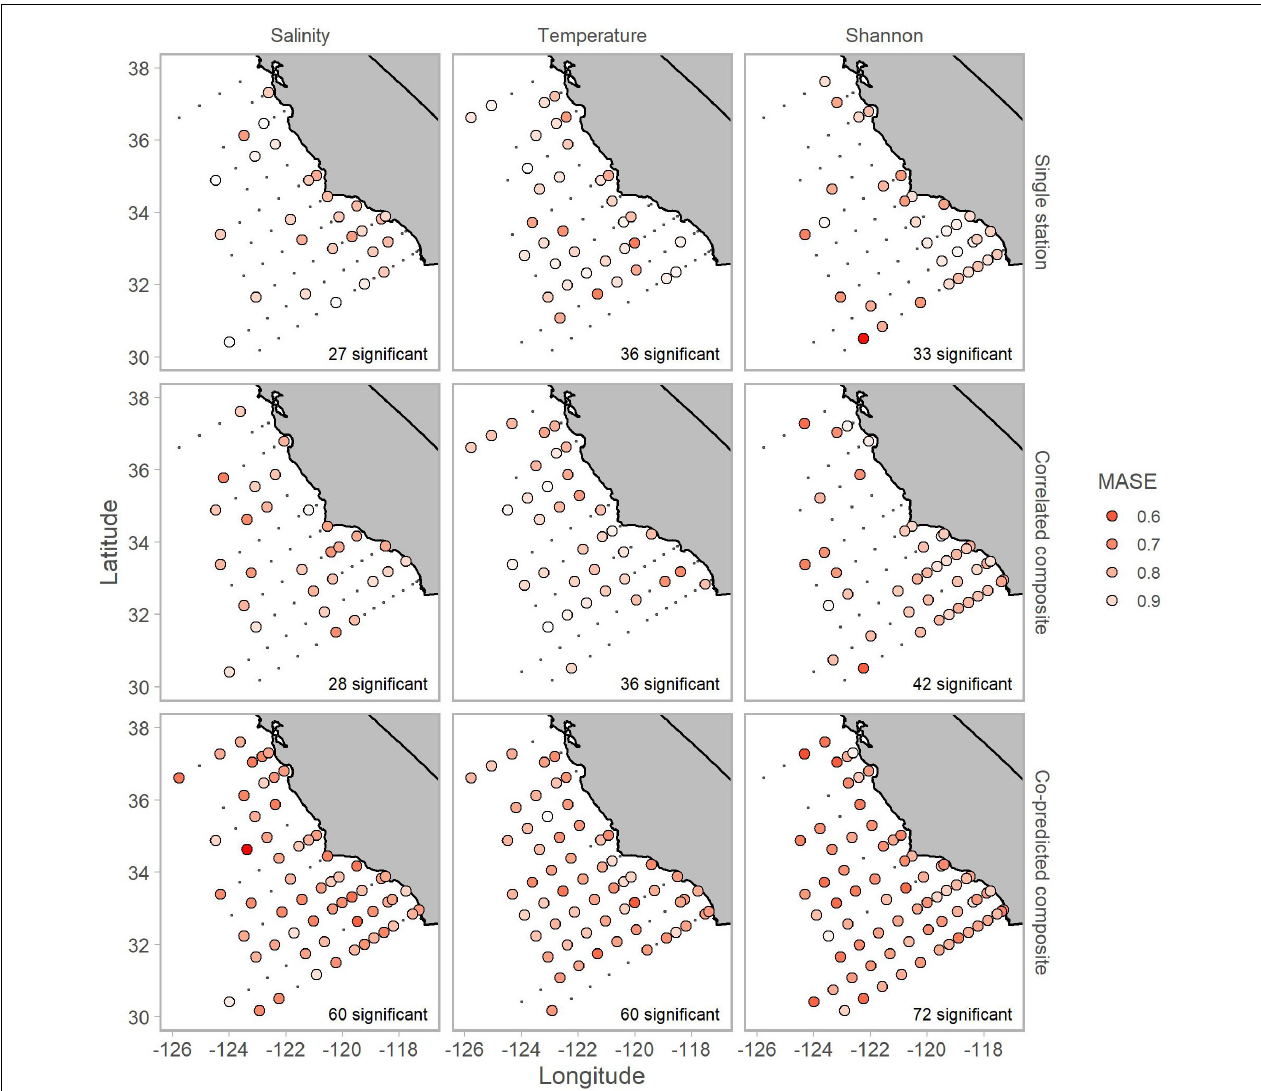
FIGURE 6 | Locations of stations with significant hindcast s-map predictive skill for salinity (left column), temperature (middle column) and Shannon index (right column). Predictions used single station (top row), correlated composite libraries (middle row) and co-predicted composite libraries (bottom row). Shading indicates MASE values. A MASE of 0.6, for example, indicates that the error from s-map predictions is on average 60% of the error from a naïve predictor (i.e., lagged observation). The number of significant stations is shown in the bottom right of each